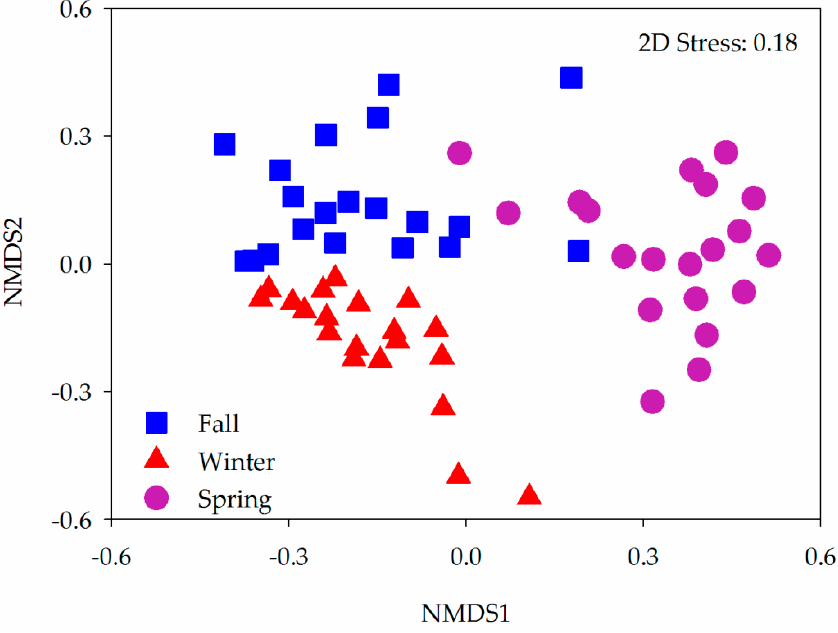
Figure 5. Non-metric multidimensional scaling (NMDS) showing intestinal bacterial community compositions of hooded cranes across three seasons. Table 1. Differences in the bacterial community composition based on the similarity test of ANOSIM.